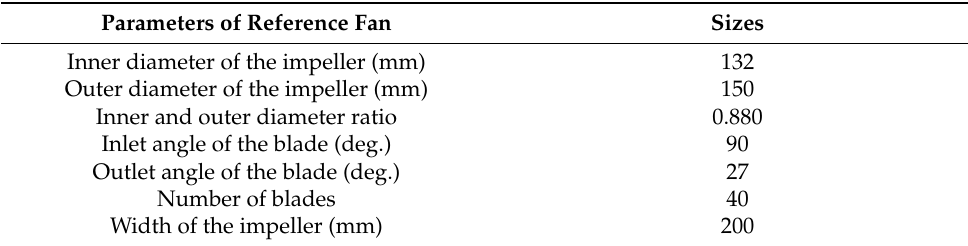
Table 1. Main geometric parameters of the fan